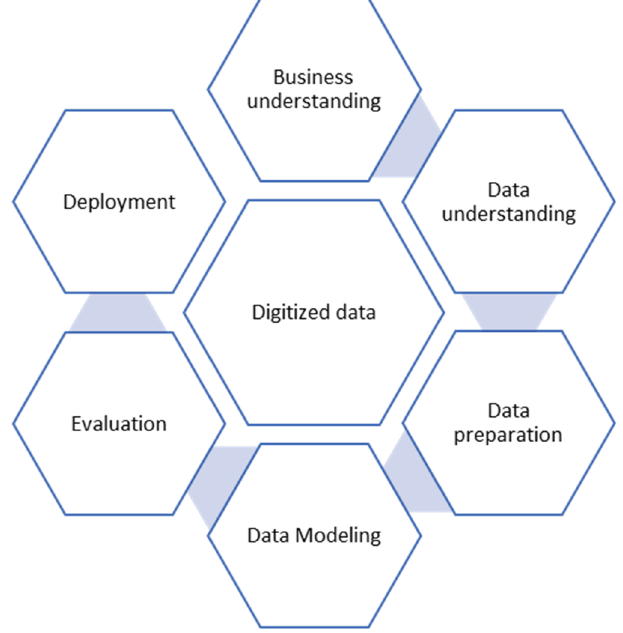
Figure 3. Phases in the CRISP-DM framework.